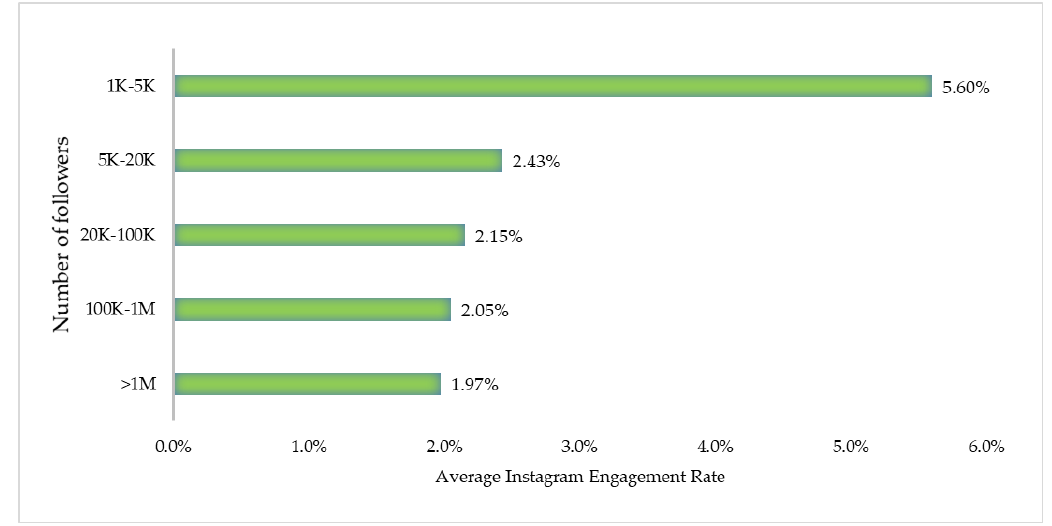
Figure 1. Average engagement rate on Instagram.